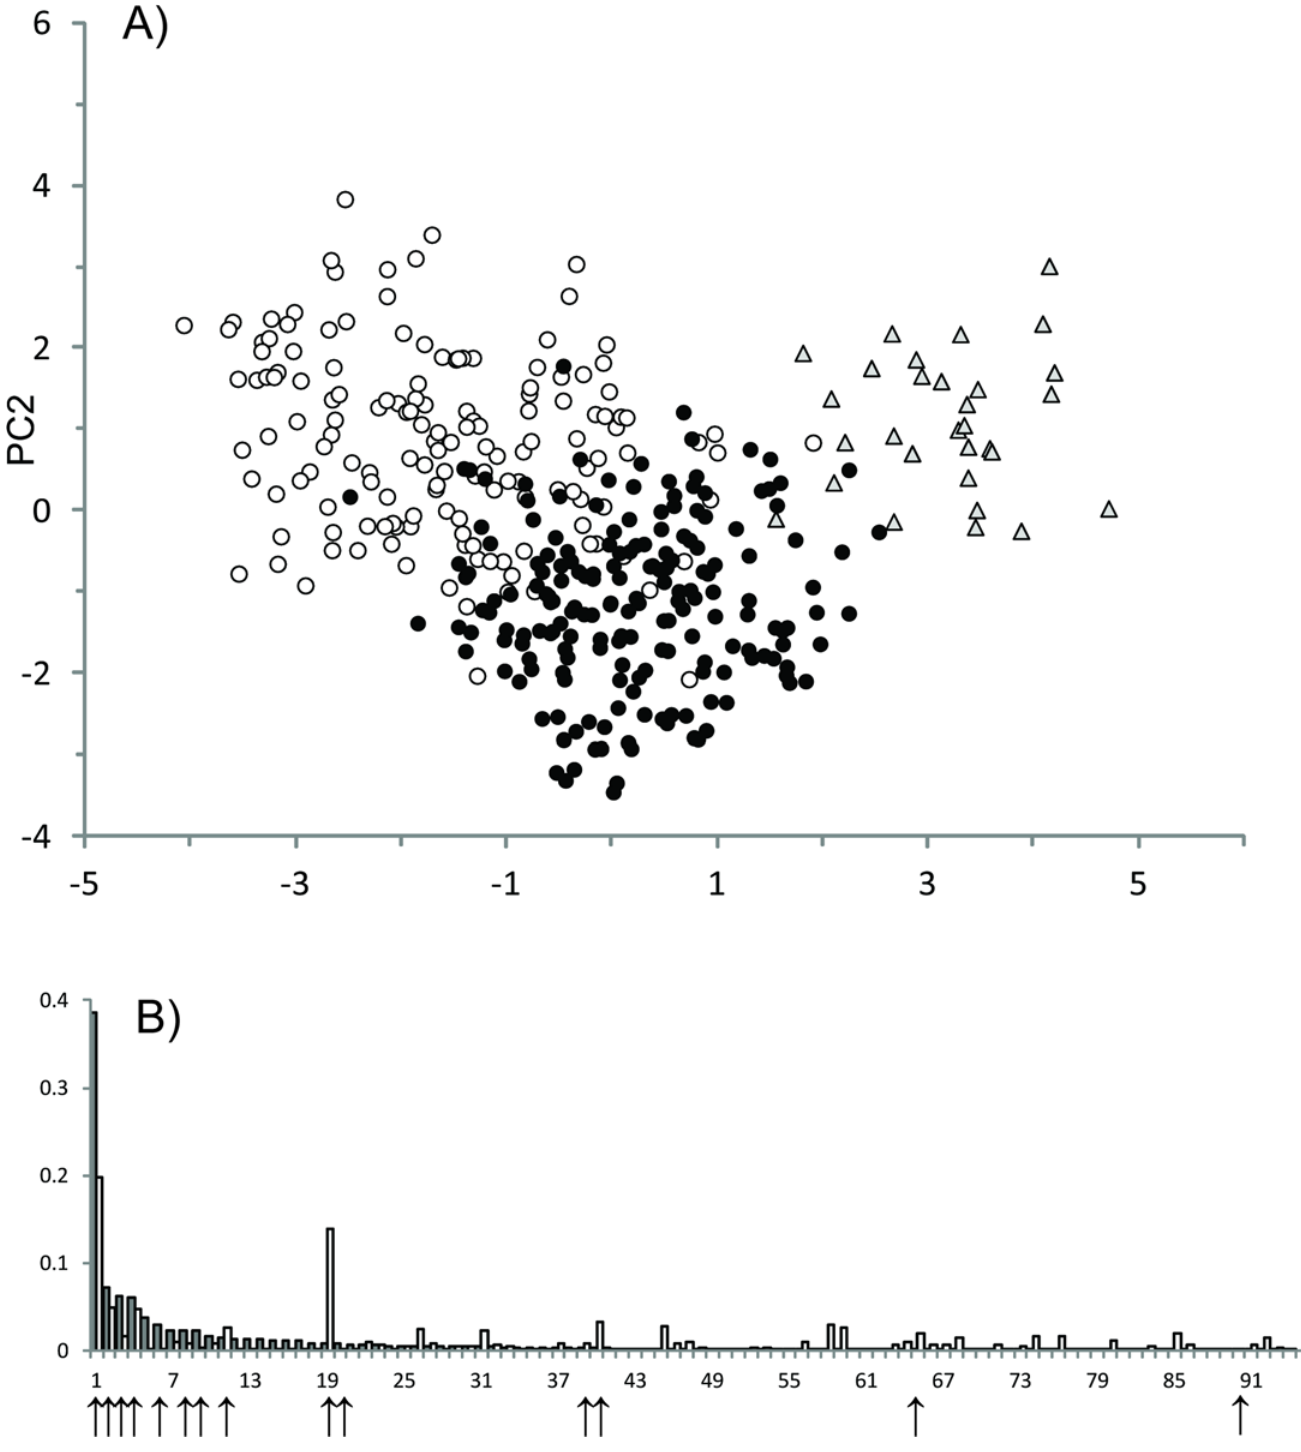
Fig 3. Genotypes form three ecotype associated clusters strongly driven by outlier loci. (A) DAPC clustering for the first two principal components (PCs) explaining 98% of the variation. Filled black dots: Baltic Sea AS; open circles: Baltic Sea SS; grey triangles: North Sea AS. See Table 1 for sample details. (B) proportion of variation contributed to PC1 (grey bars) and PC2 (open bars) by individual loci. Outlier loci are indicated by vertical arrows.